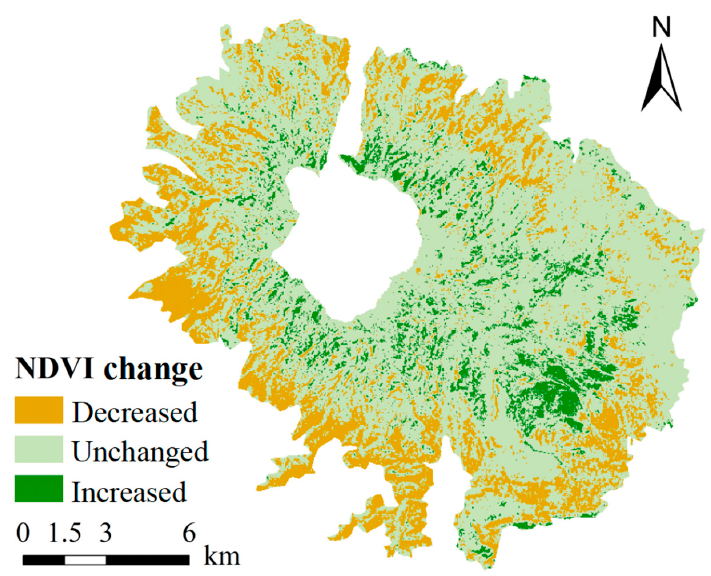
Figure 7. Spatial distribution of NDVI change from 1988 to 2017.